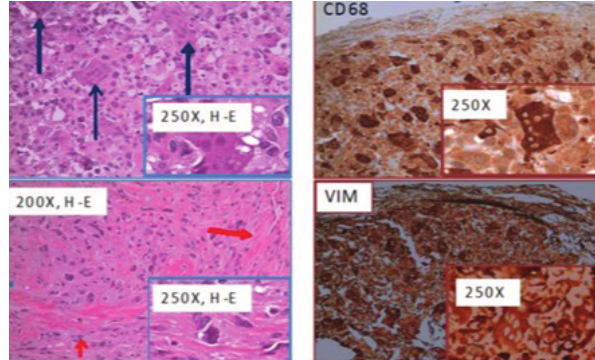
Figure 3: Microscopic evaluation showed a lesion mostly formed of spindle-shaped malignant cells arranged in a fascicular/stori- form pattern of growth, with several highly pleomorphic elements, was observed in the corion. (green arrow). Moreover, a significant number of osteoclast-like giant-cells, with hyperchromatic and slightly atypical nuclei, were found (blue arrows). A focal collagen deposition, consisting of bundles of fibrillar eosinophilic material, was associated (red arrows). At the immunohistochemical exam, the lesion showed a strong and diffuse positivity to vimentin and a mild reactivity to CD68, more prominently in the giant cells counterpart. Finally, a diagnosis of malignant fibrous histiocytoma (MFH) was region (2 of these of epiglottis, 4 of aryepiglottic fold, 1 of Morgagni ventricle, 1 not specified); 19 in glottis region (17 of vocal cords, 1 of anterior commissura, 1 not specified); 8 in the subglottis region; 6 in unspecified regions; 1 in hemilarynx and 1 case of transglottic cancer (vocal cord and Morgagni ventricle) (Table 1). We have indicated treat-